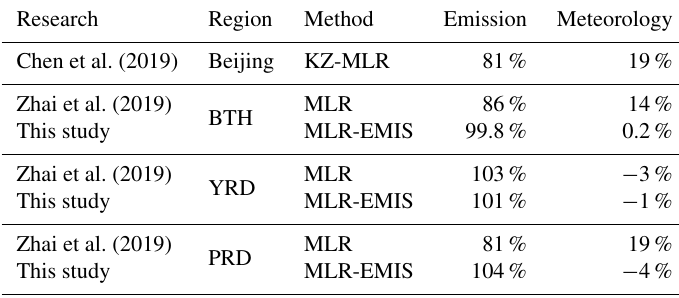
Table 1. Comparison of the contribution of emissions and meteorological conditions to the observed PM 2 . 5 trends in 2013–2018 (2013–2017 for Chen et al., 2019).